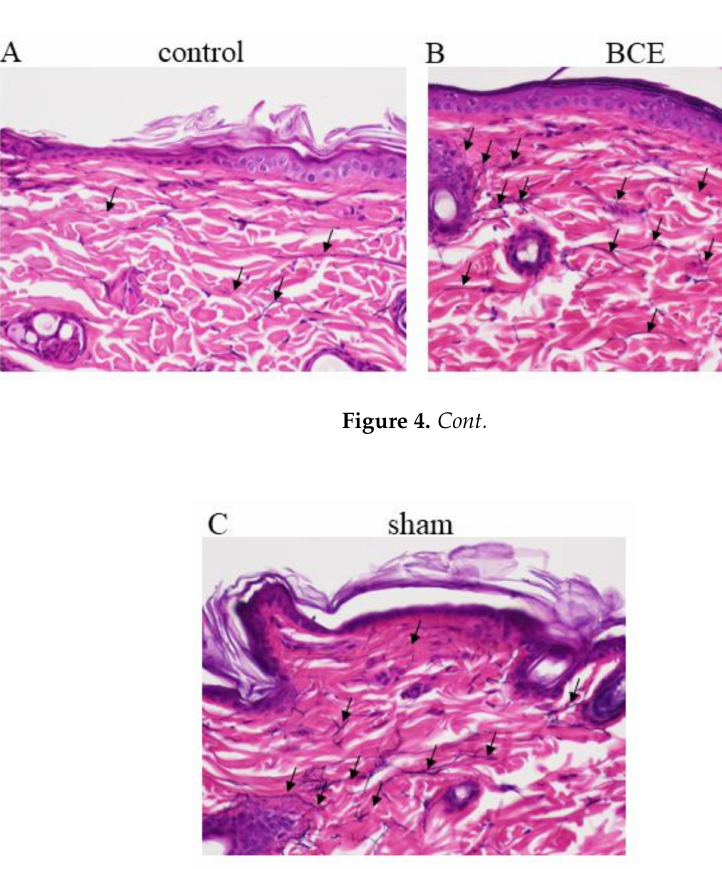
Figure 4. Light microscopy image of elastic fiber staining of skin from control (OVX + 0% BCE; ( A )), OVX + 3% BCE ( B ), and sham surgery rats ( C ). Images are at 200 ×